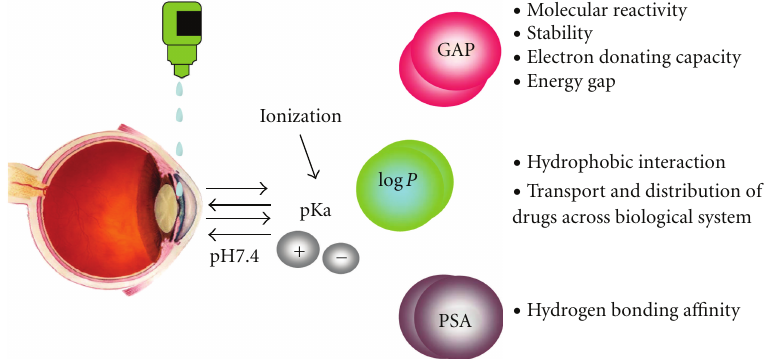
Figure 4: Pictorial representation of the newly developed QSPR model depicting various factors a ff ecting the penetration of topically applied